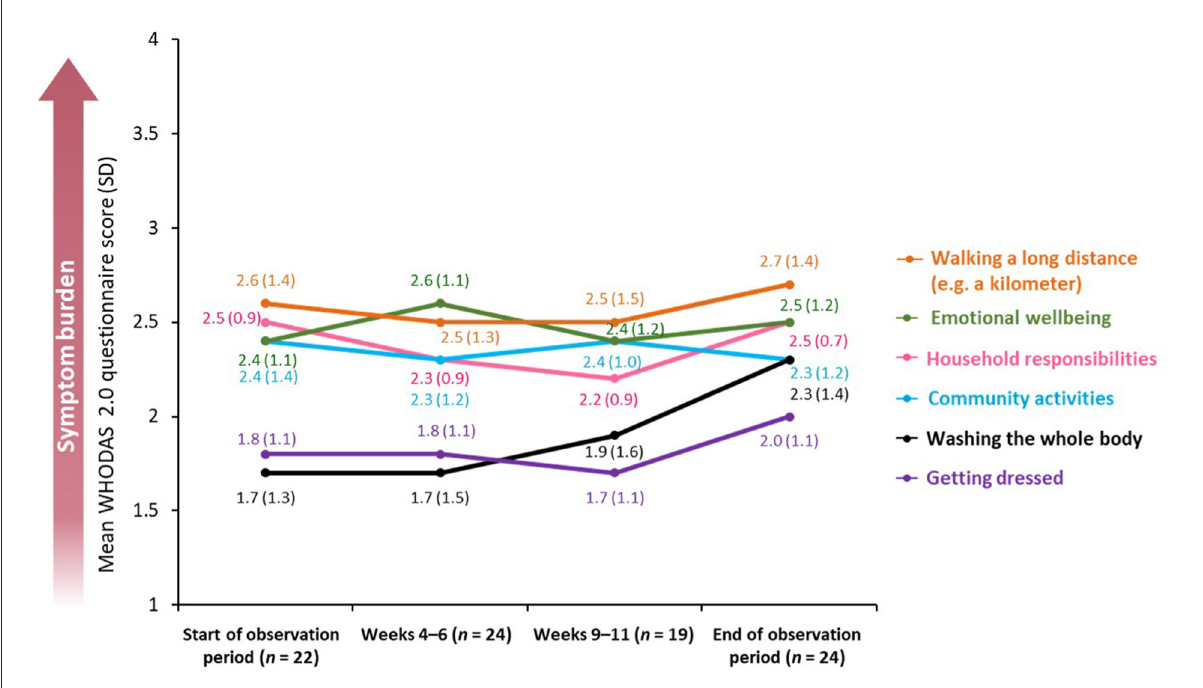
FIGURE6 Mean WHODAS 2.0 questionnaire score across a BoNT-A treatment cycle. BoNT-A, botulinum neurotoxin A; WHODAS 2.0, World Health Organization Disability Assessment Schedule 2.0; SD, standard